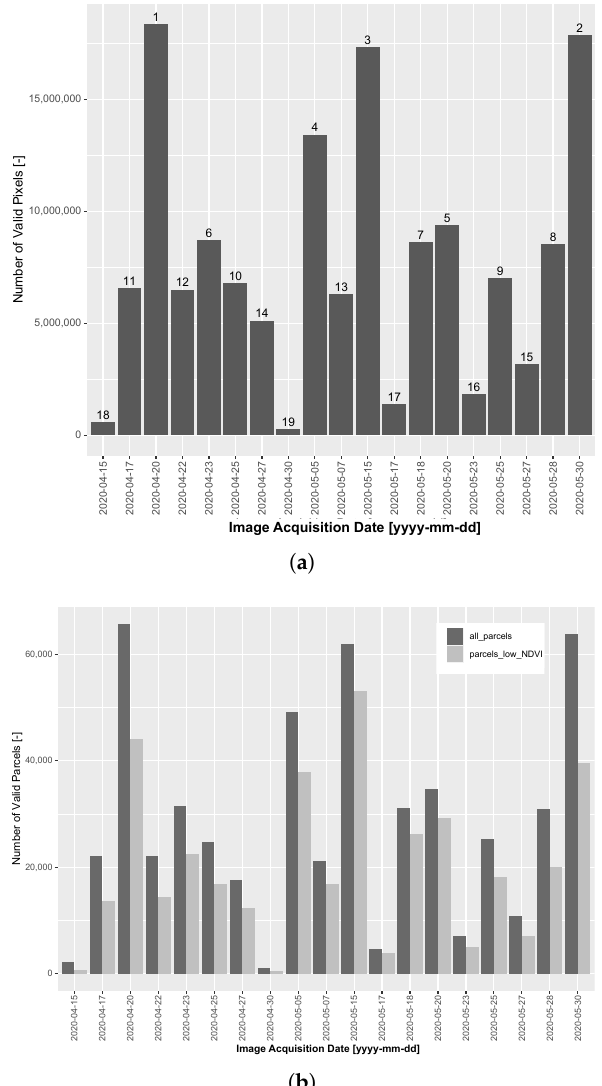
Figure 6. Sentinel-2 acquisitions from mid-April to end-May and the corresponding valid data. ( a ) The number of valid parcel pixels and the corresponding ranking of each date of acquisition. ( b ) The number of valid parcels before and after the NDVI thresholding at 0.3.